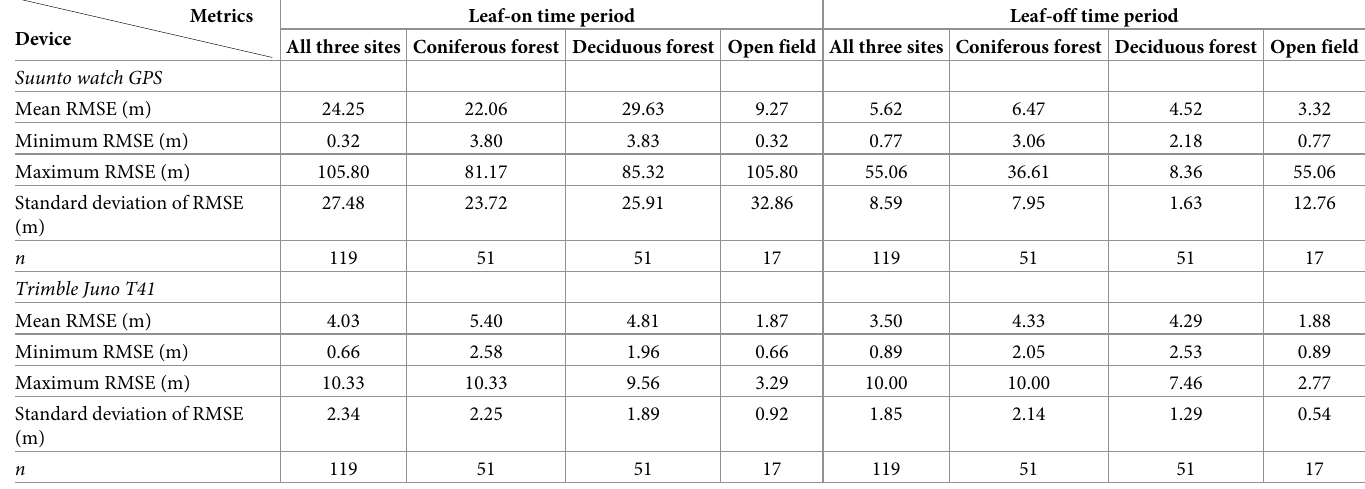
Table 2. Summary results of dataset, with outliers, of the horizontal position error of the GPS watch and mapping-grade GNSS receiver at the Whitehall Forest GPS Test Site in Athens, Georgia (USA). Metrics Device